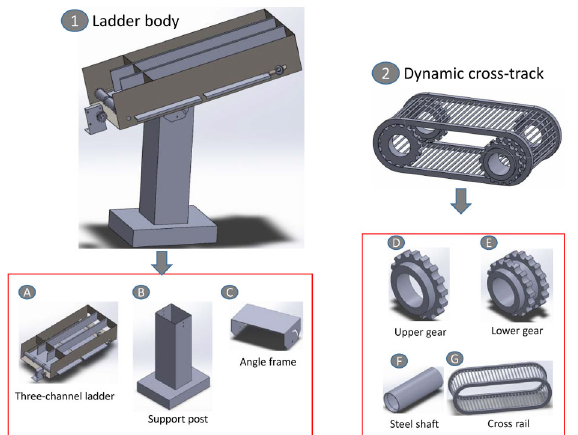
Figure 2. Mechanical design for the climbing platform. The main body of the ladder includes a three-channel ladder ( A ), a support post ( B ), and an angle frame ( C ). The dynamic cross-track includes an upper gear ( D ), a lower gear ( E ), two steel shafts ( F ), and a cross rail ( G